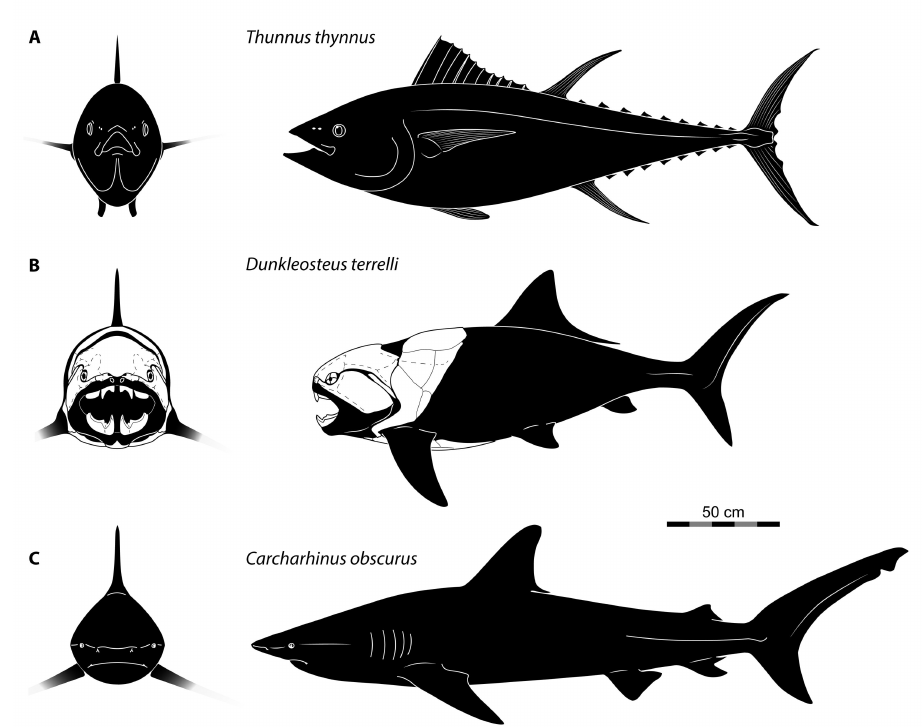
Figure 12. Silhouettes of a tuna (( A ), Thunnus thynnus ), Dunkleosteus terrelli (juvenile) ( B ), and carcharhinid shark (( C ), Carcharhinus obscurus ), all scaled to ~150 kg, showing differences in body shape of actinopterygians, arthrodires, and elasmobranchs at the same body mass. Proportions of ( A ) modeled after Rivas [203] and Russell [96]; ( B ) from present study and Engelman [115], based on CMNH 7424 and CMNH 6090; C modeled after 3.2 m individual in Garrick [37]. Note tunas are unusually wide for actinopterygians, the figured individual of C. obscurus is comparatively deep- bodied for Carcharhinus , and the length of D. terrelli might be a slight overestimate if arthrodires show ontogenetic allometry similar to actinopterygians. Thus, these three specimens understate the differences in body shape between the three major clades. Drawings by Russell